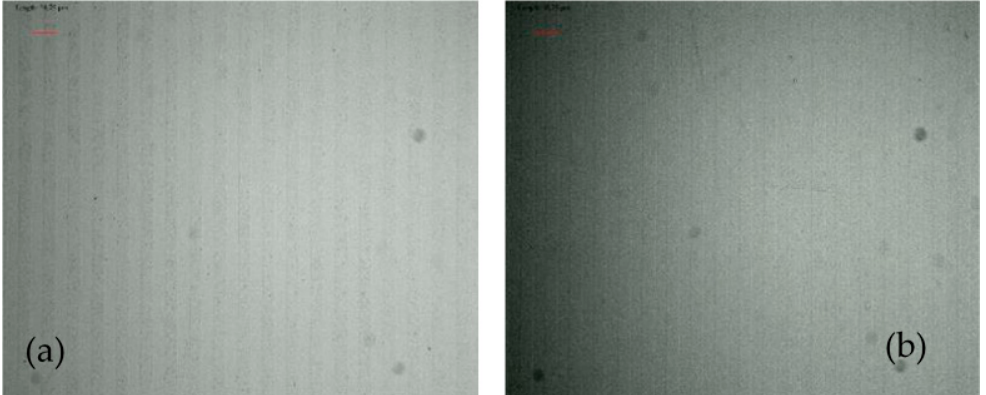
Figure 9. Microphotographs of c+ ( a ) and c- ( b ) polar surfaces in 5 mm thick PPKTP. The selective chemical etching was used to reveal a ferroelectric domain structure with 38.75 µm periodicity.